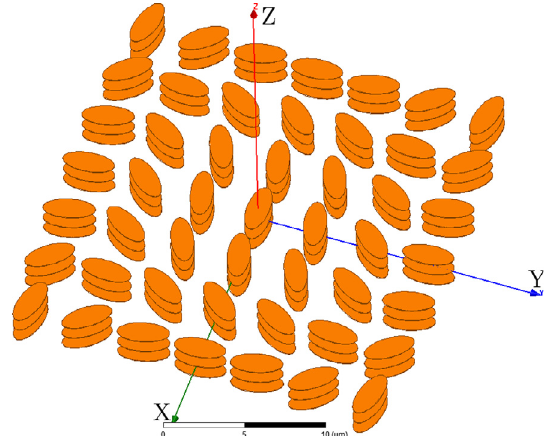
Figure 9. Full-wave simulation model of a 2D-focusing transmit- array lying in the X - Y